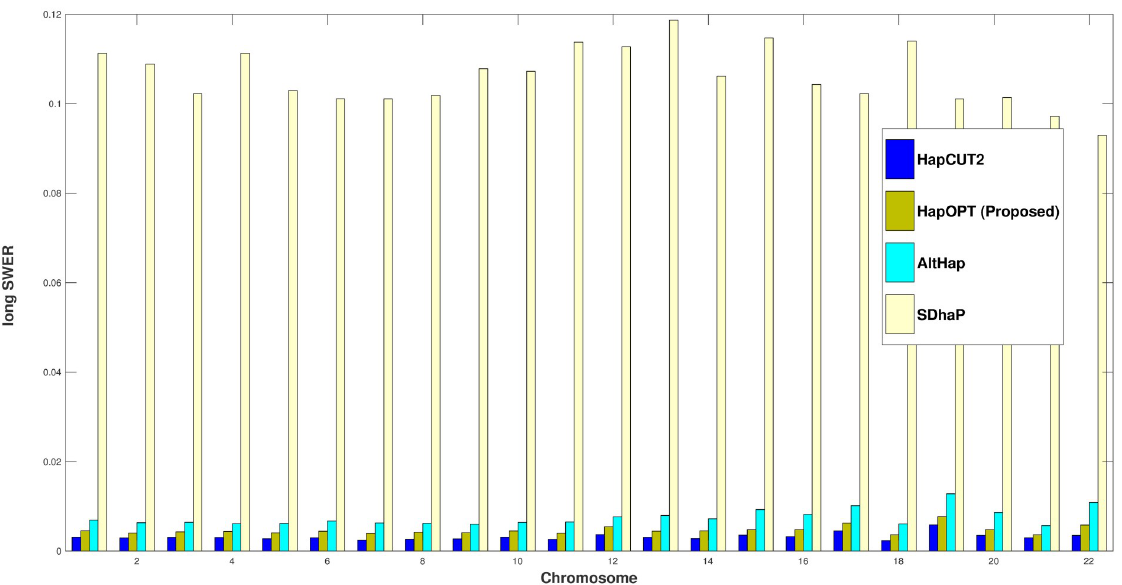
Fig 4. Long SWER of HapOPT, HapCUT2, AltHap, and SDhaP on real fosmid data.